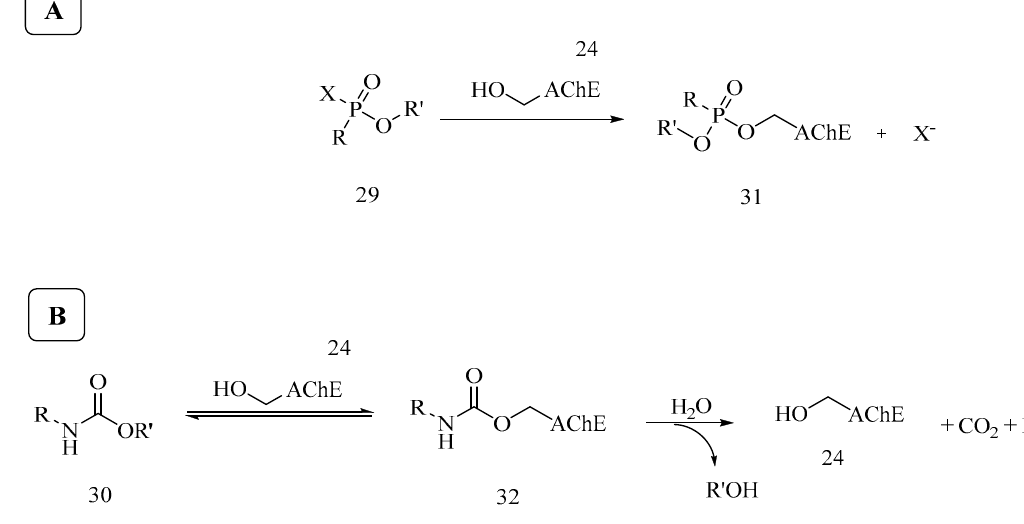
Scheme 3. Reactions of AChE with different inhibitors.